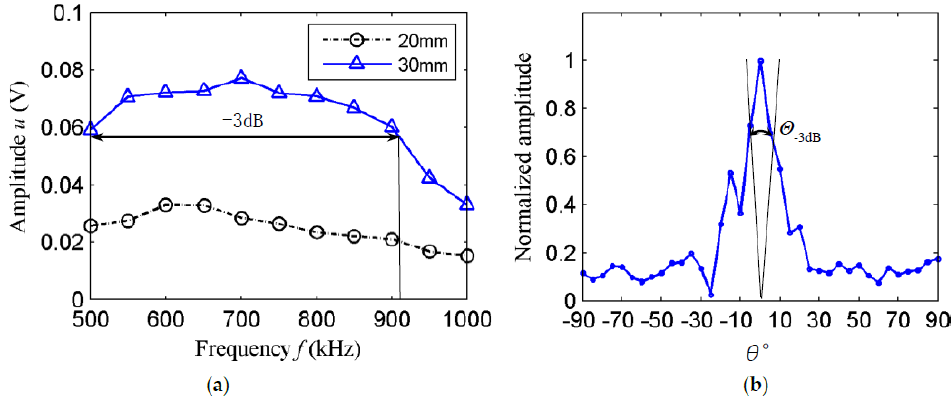
Figure 14. Transducer performance tests: ( a ) frequency-response test; ( b ) directivity test.